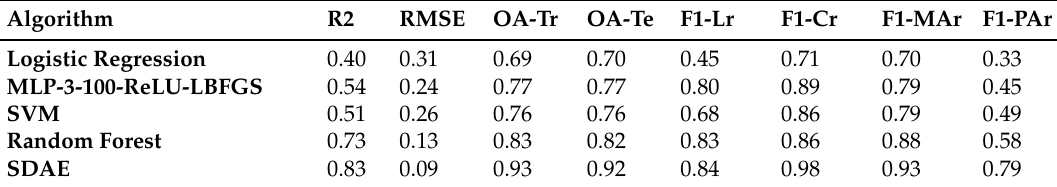
Table 5. Classification results for Tehran.